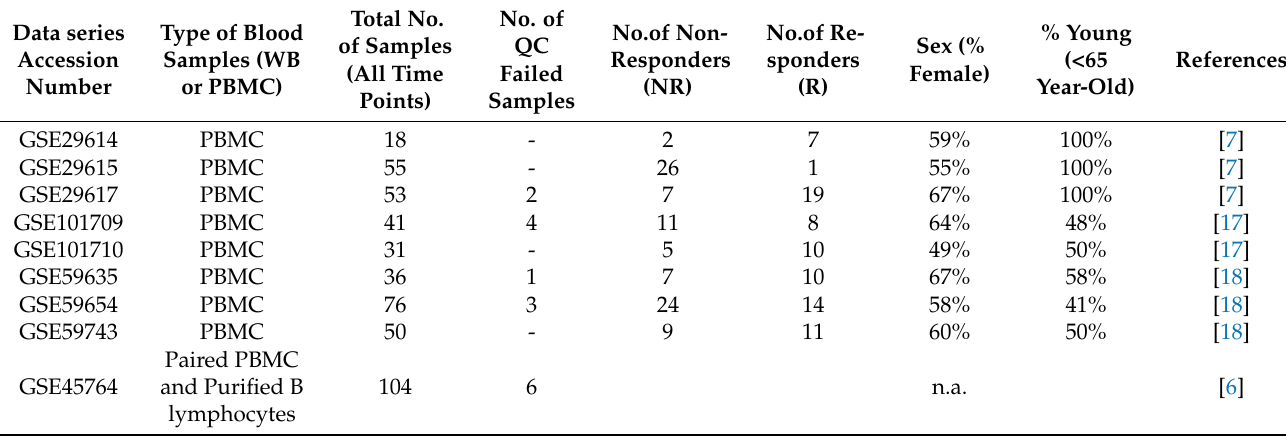
Table 1. List of PBMC gene expression datasets used in this study. (n.a.: not